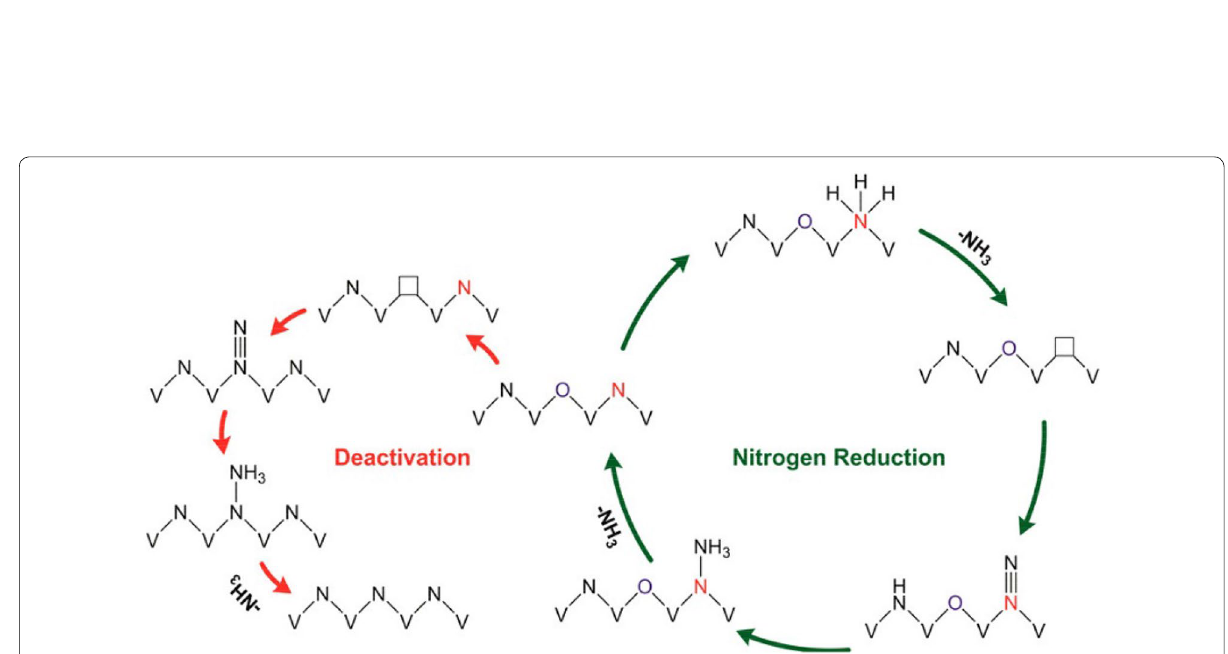
Fig. 7 The proposed reaction pathway for N 2 reduction on VN 0.7 O 0.45 via MvK mechanism and the deactivation of the catalyst (Reproduced with permission [35] Copyright 2018, American Chemical Society